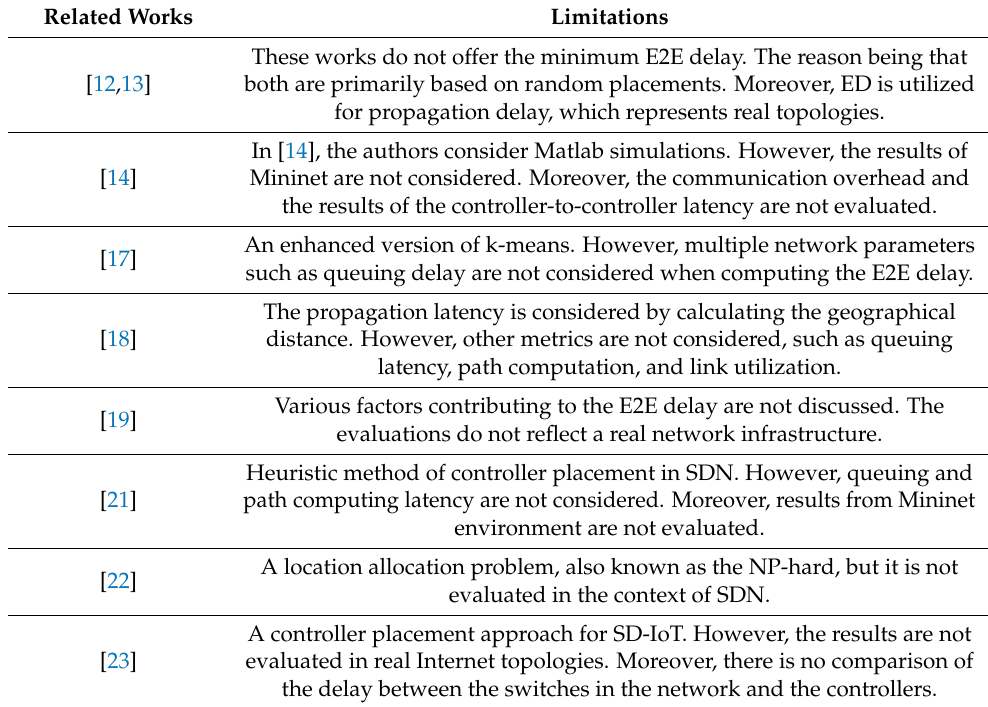
Table 1. Literature works and